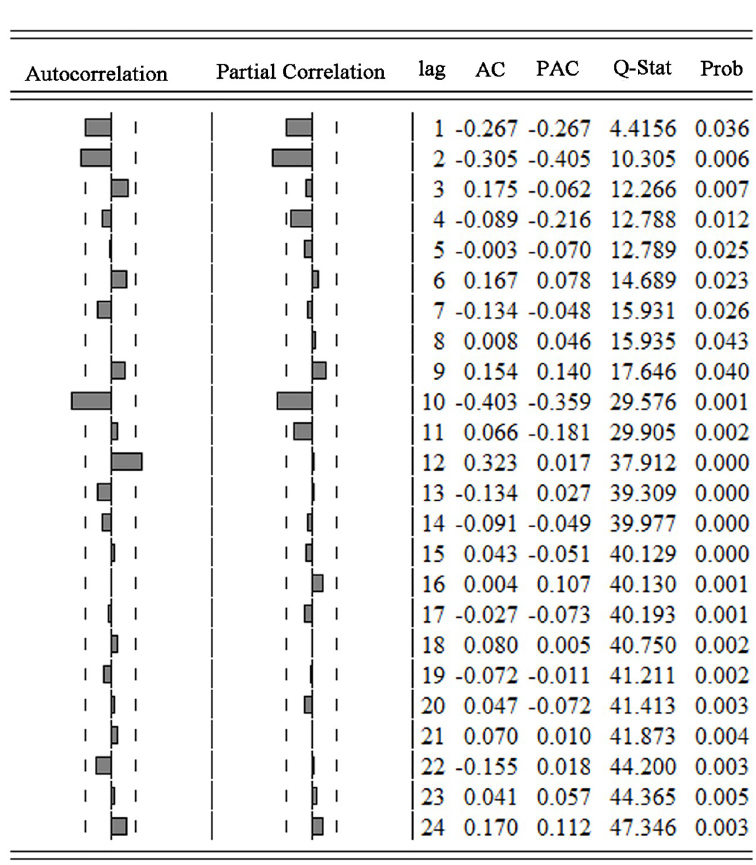
Fig 3. ACF and PACF diagrams after first-order difference of PTB cases in Urumqi.